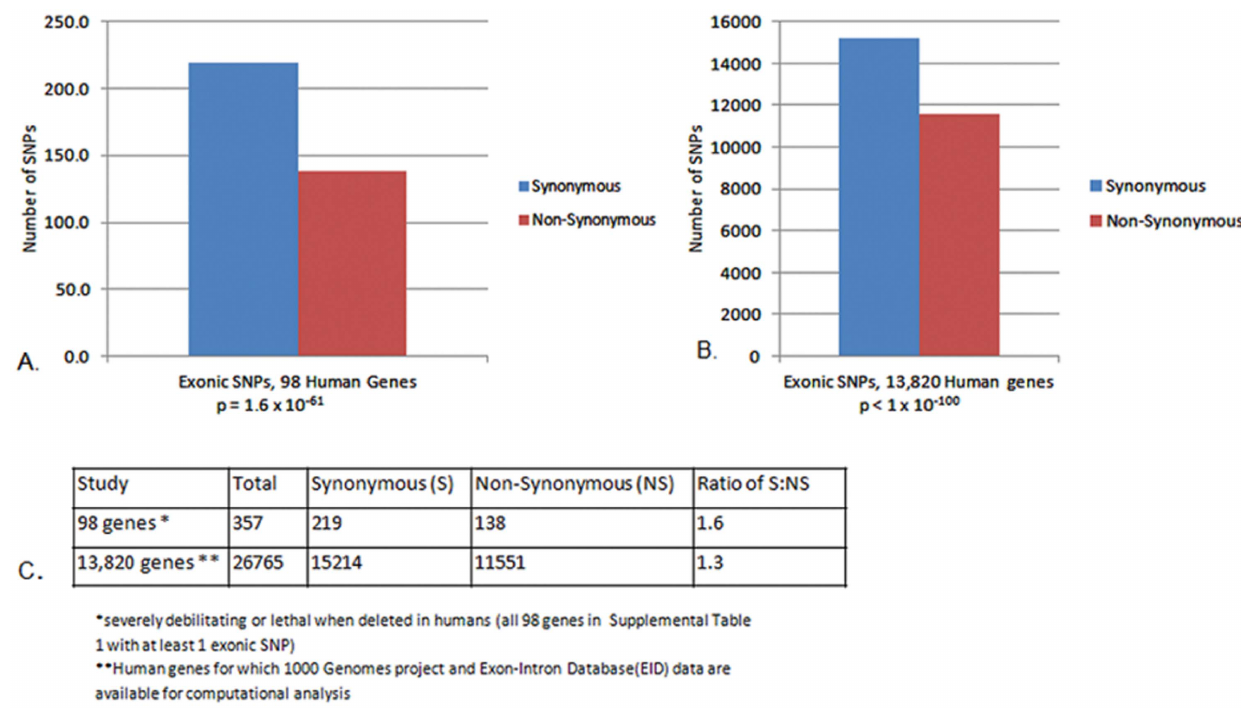
Figure 2. Synonymous and non-synonymous SNP incidence. A: Exonic SNPs in 98 genes known to be lethal or severely debilitating if deleted (a subset of genes in Figure 1A with at least one exonic SNP (Table S2)); B: Survey of 13,820 genes for which data was accessible from the Exon-Intron Database (http://www.utoledo.edu/med/depts/bioinfo/database.html) and 1000 Genomes (http://pilotbrowser.1000genomes.org/index.html); C: Composite data used to generate Panels A and B. All genes from Figure 1A with at least one exonic SNP were examined. Each gene was analyzed in the 1000 Genome Pilot Browser (http://pilotbrowser.1000genomes.org/index.html) including designation as synonymous vs. non-synonymous. The synonymous SNP enhancement agrees with earlier population-based studies in Drosophila , human, and other species [35,36,37,84]. To confirm that the ratio of synonymous to non-synonymous SNPs calculated from the set of 98 disease-associated genes was representative of the larger population, a bootstrapping analysis was conducted. Two-thousand samples of 98 genes were randomly selected from the larger gene cohort. Synonymous to non-synonymous ratios were used to determine a mean for each set of ninety-eight chosen in this manner. The overall mean of 2,000 samples was used to calculate both confidence interval and a 2-tailed t-test comparing the means of the 98 disease-associated genes and the mean